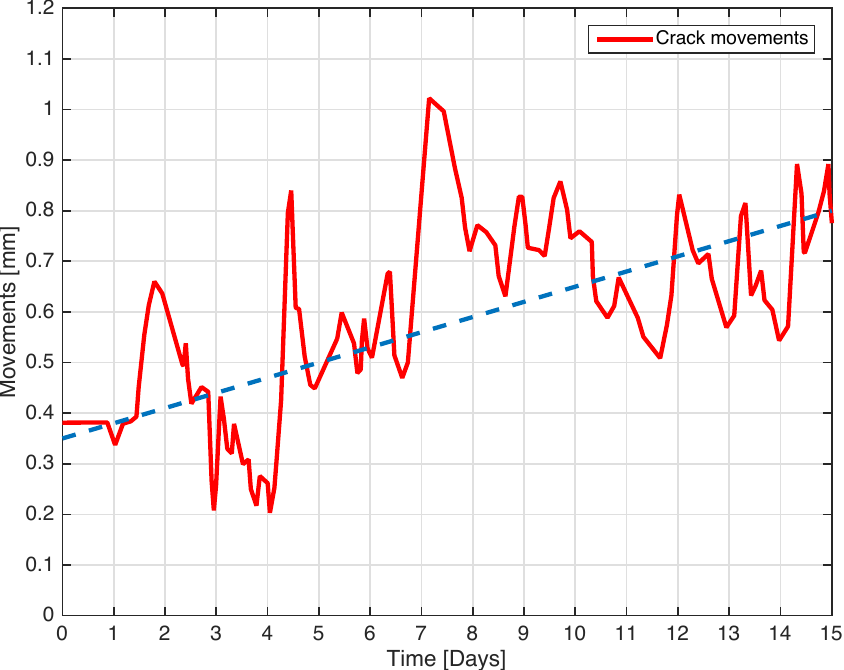
Figure 15. Crack movements vs. time. The tag placed on position B in the north side of the building, showing a dangerous situation with possible